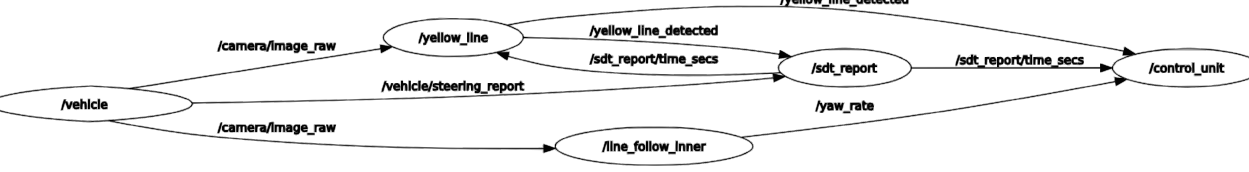
Figure 4. Flow chart of ROS node architecture generated using the rqt_graph plugin in